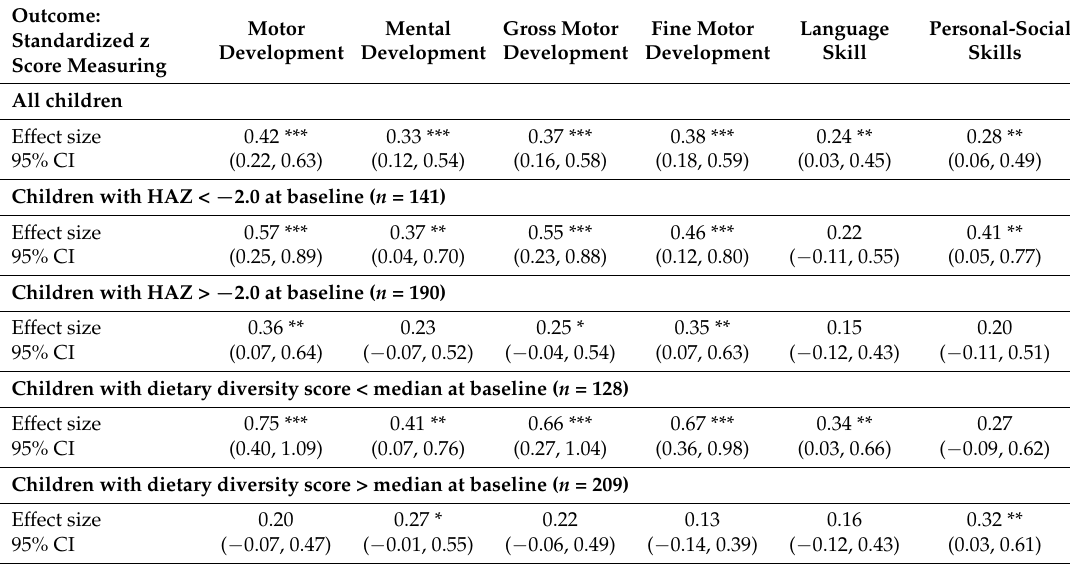
Table 2. The effects of spirulina intervention on child development scores.